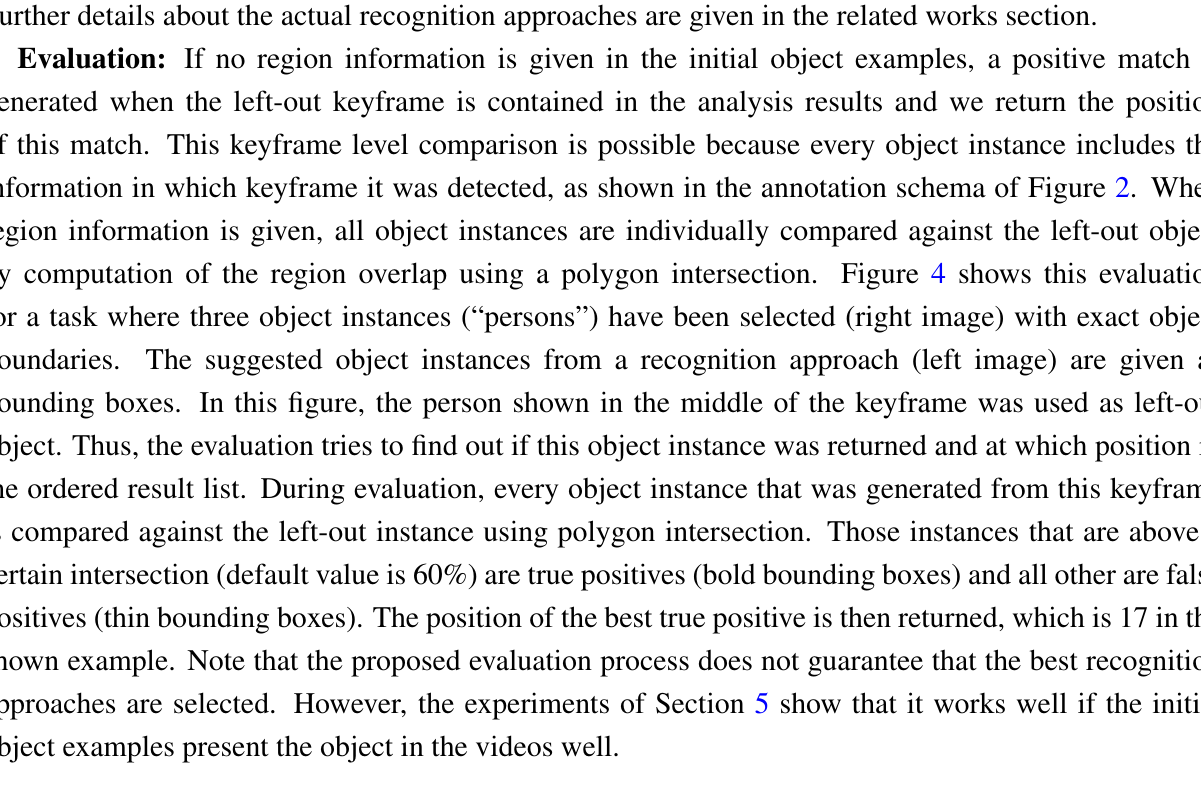
Figure 4. Evaluation for the first iteration of the one-left-out approach. Analysis